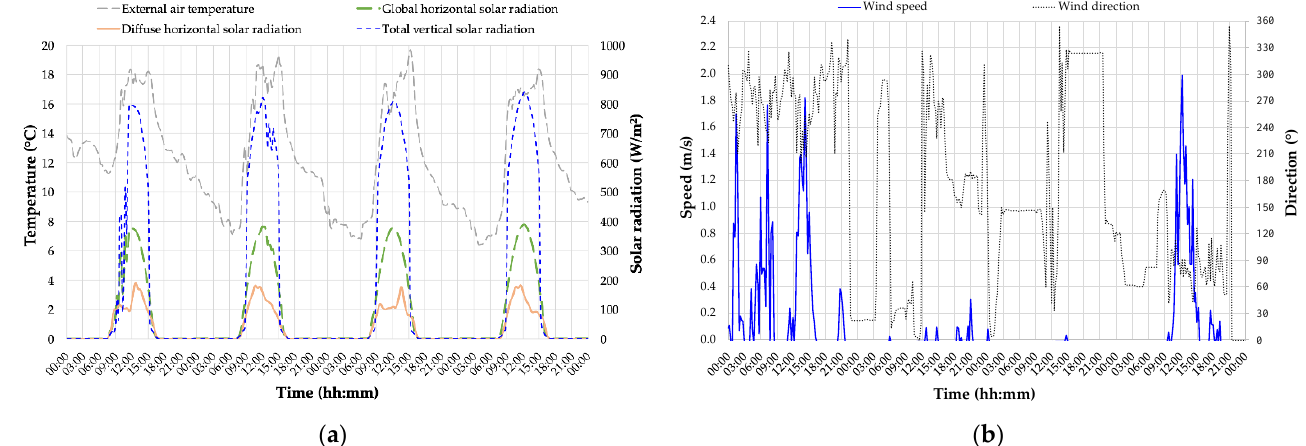
Figure 6. Weather conditions during four typical acquisition days: ( a ) solar radiation and temperature; ( b ) wind speed and wind direction.